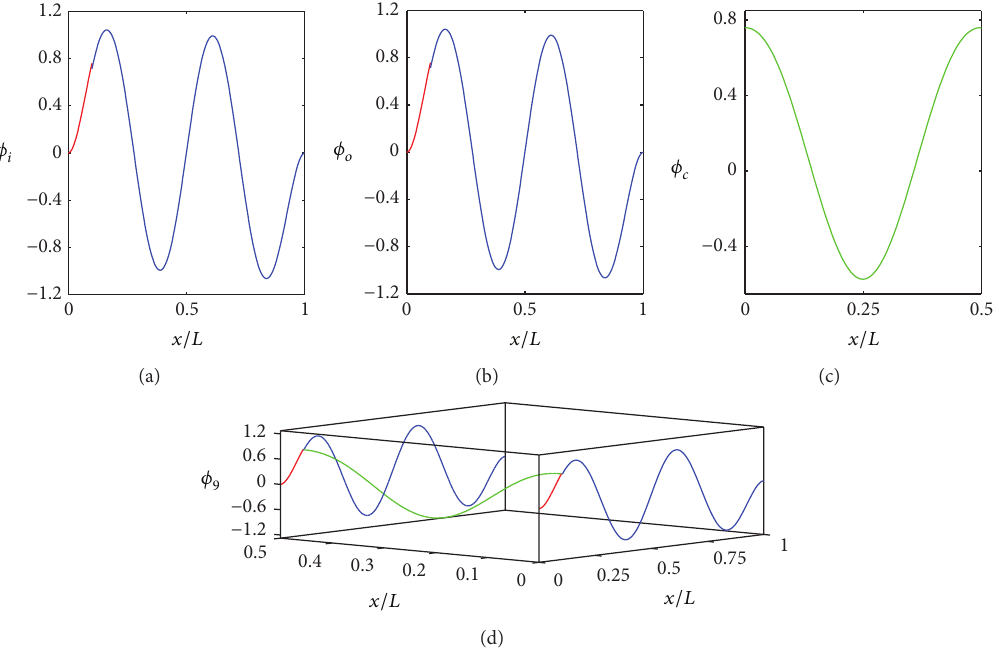
Figure 10: Ninth mode shape of the filter: (a) input, (b) output, (c) coupling beams, and (d) combination of (a), (b), and (c).